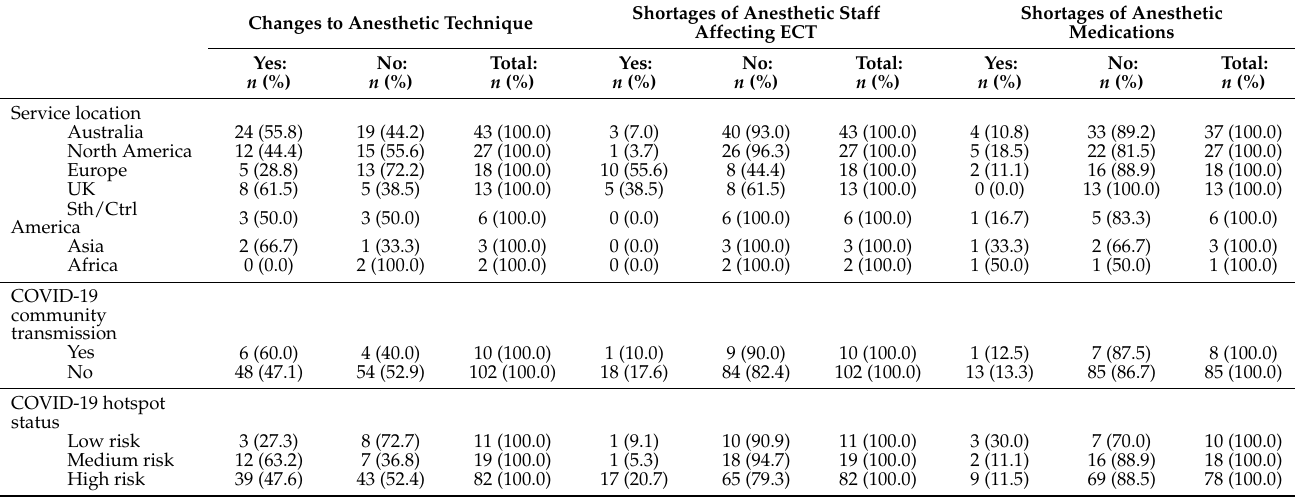
Table 3. Cross-tabulation of key impact, service, and